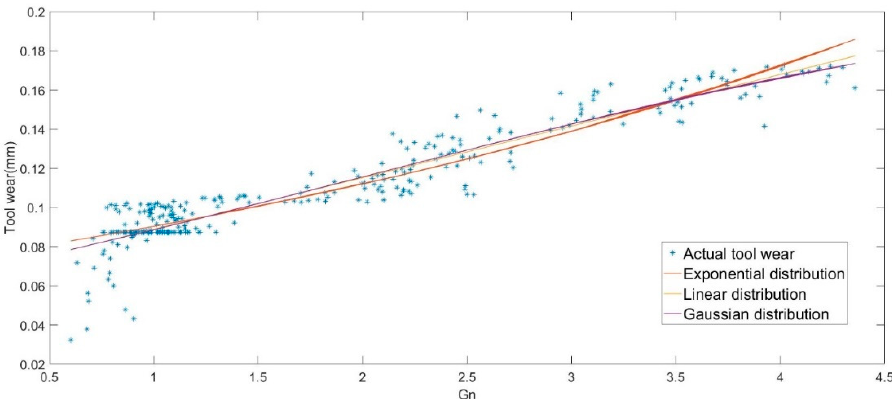
Figure 7. The tool wear fitting distribution figure.